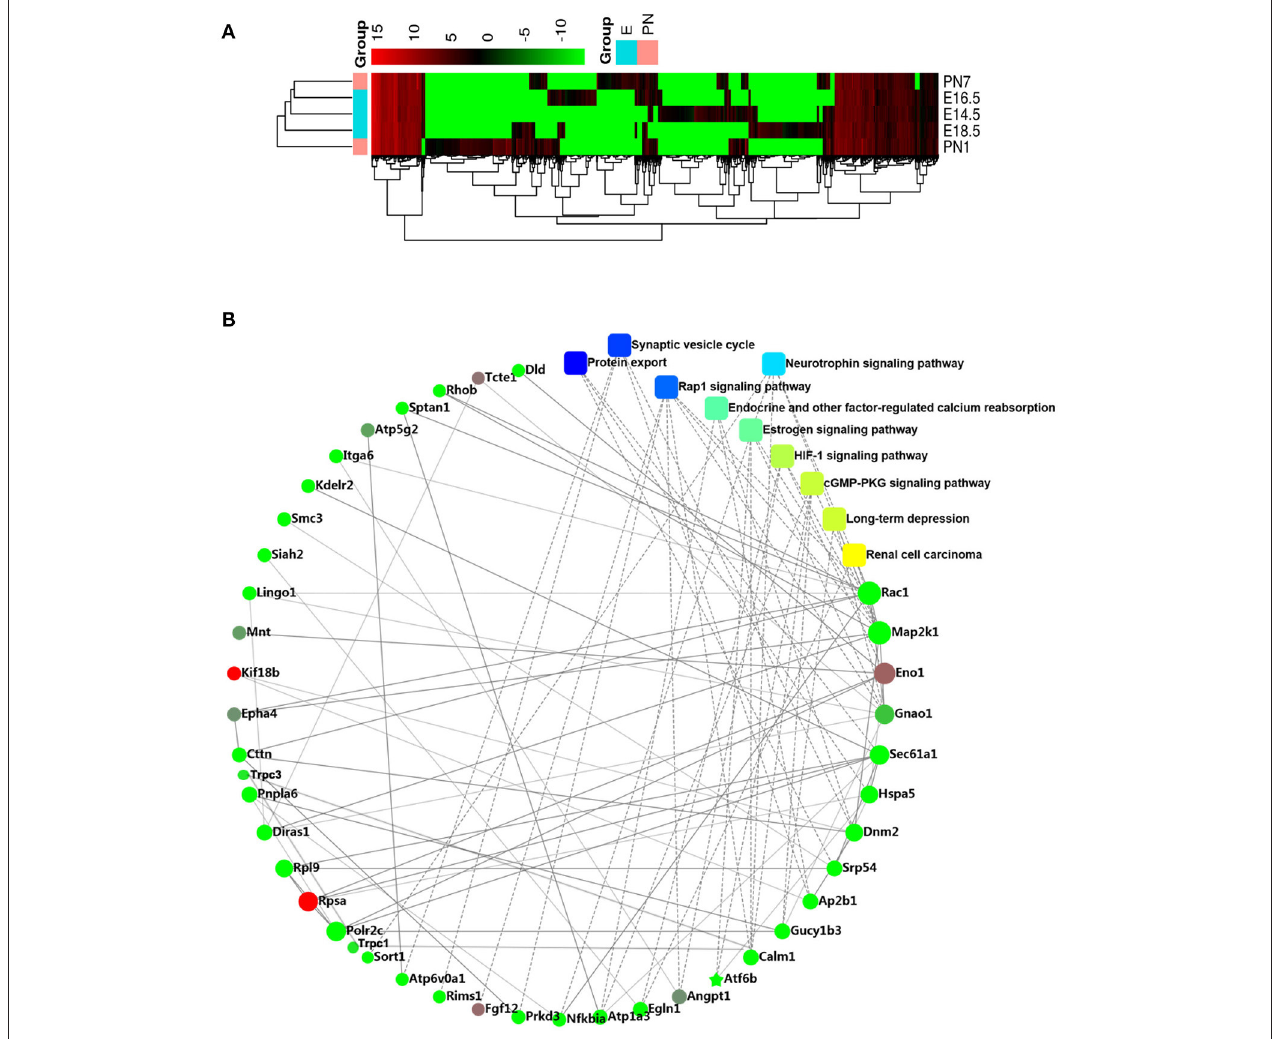
FIGURE 1 | RNA-seq analysis (A) Heatmap showes the relative expression patterns of differential genes across all development stages. (B) Protein–protein interaction network of the differentially expressed genes